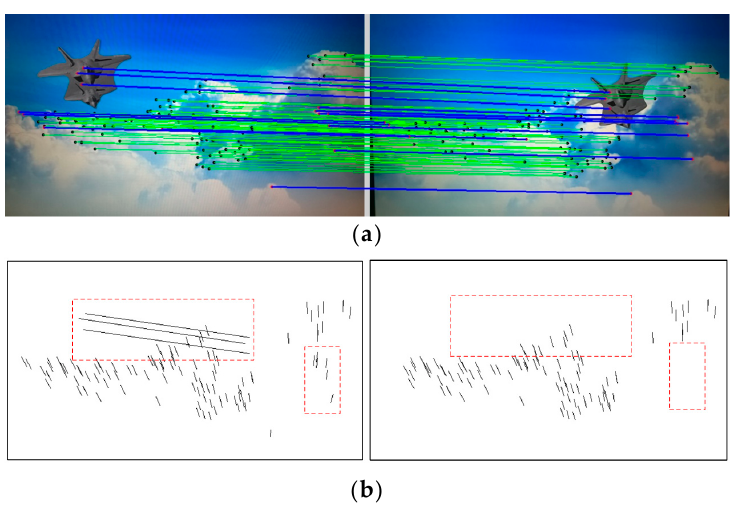
Figure 14. Matching pairs ( a ) and local motion vectors ( b ) for the flight vehicle target.